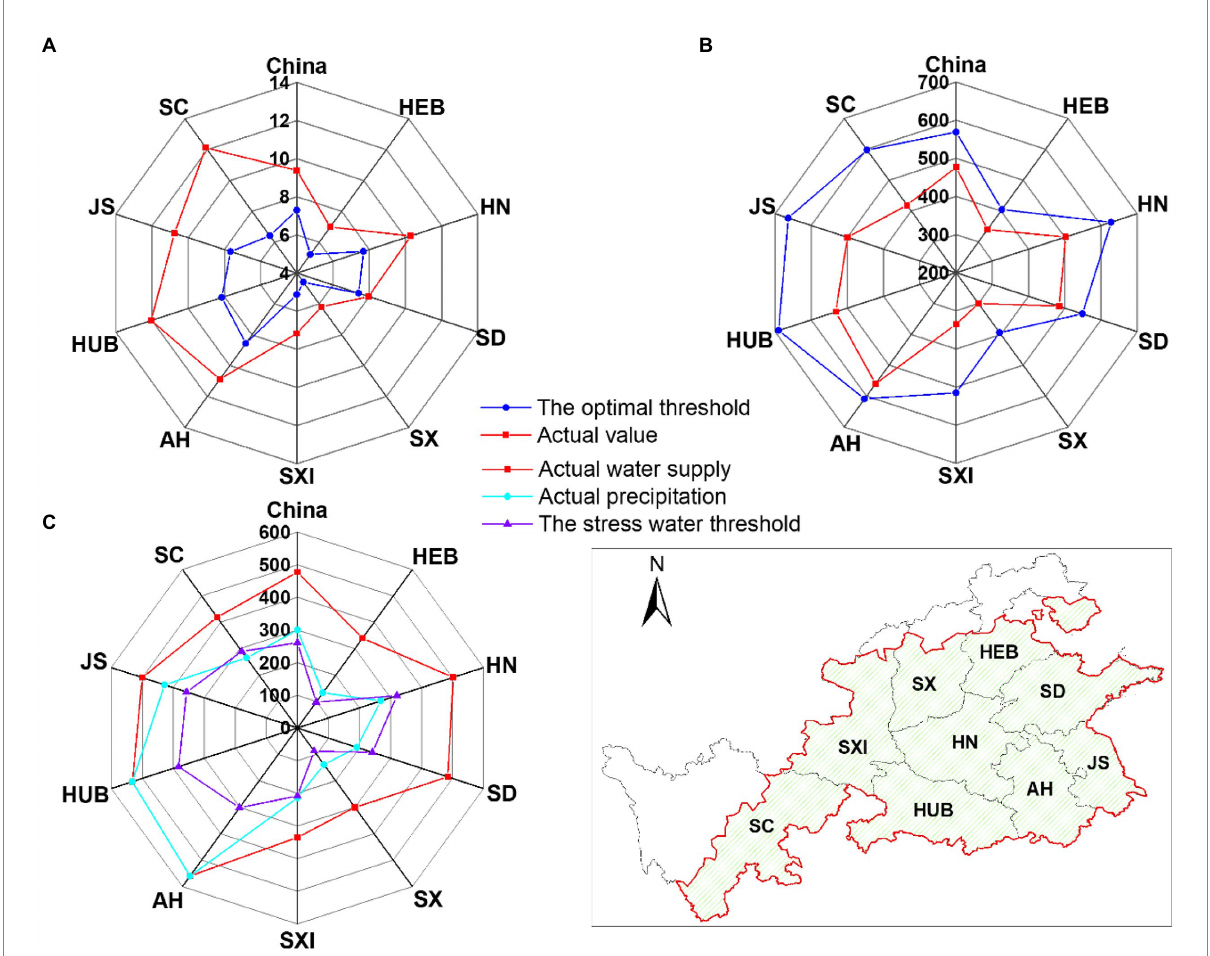
FIGURE 5 The optimal thresholds and actual factor values from 1996 to 2017. (A) Optimal temperature threshold for winter wheat production and its average temperature during the growing season. (B) Optimal water threshold for winter wheat production and its average water supply. (C) Water stress threshold for winter wheat production and the actual water supply and